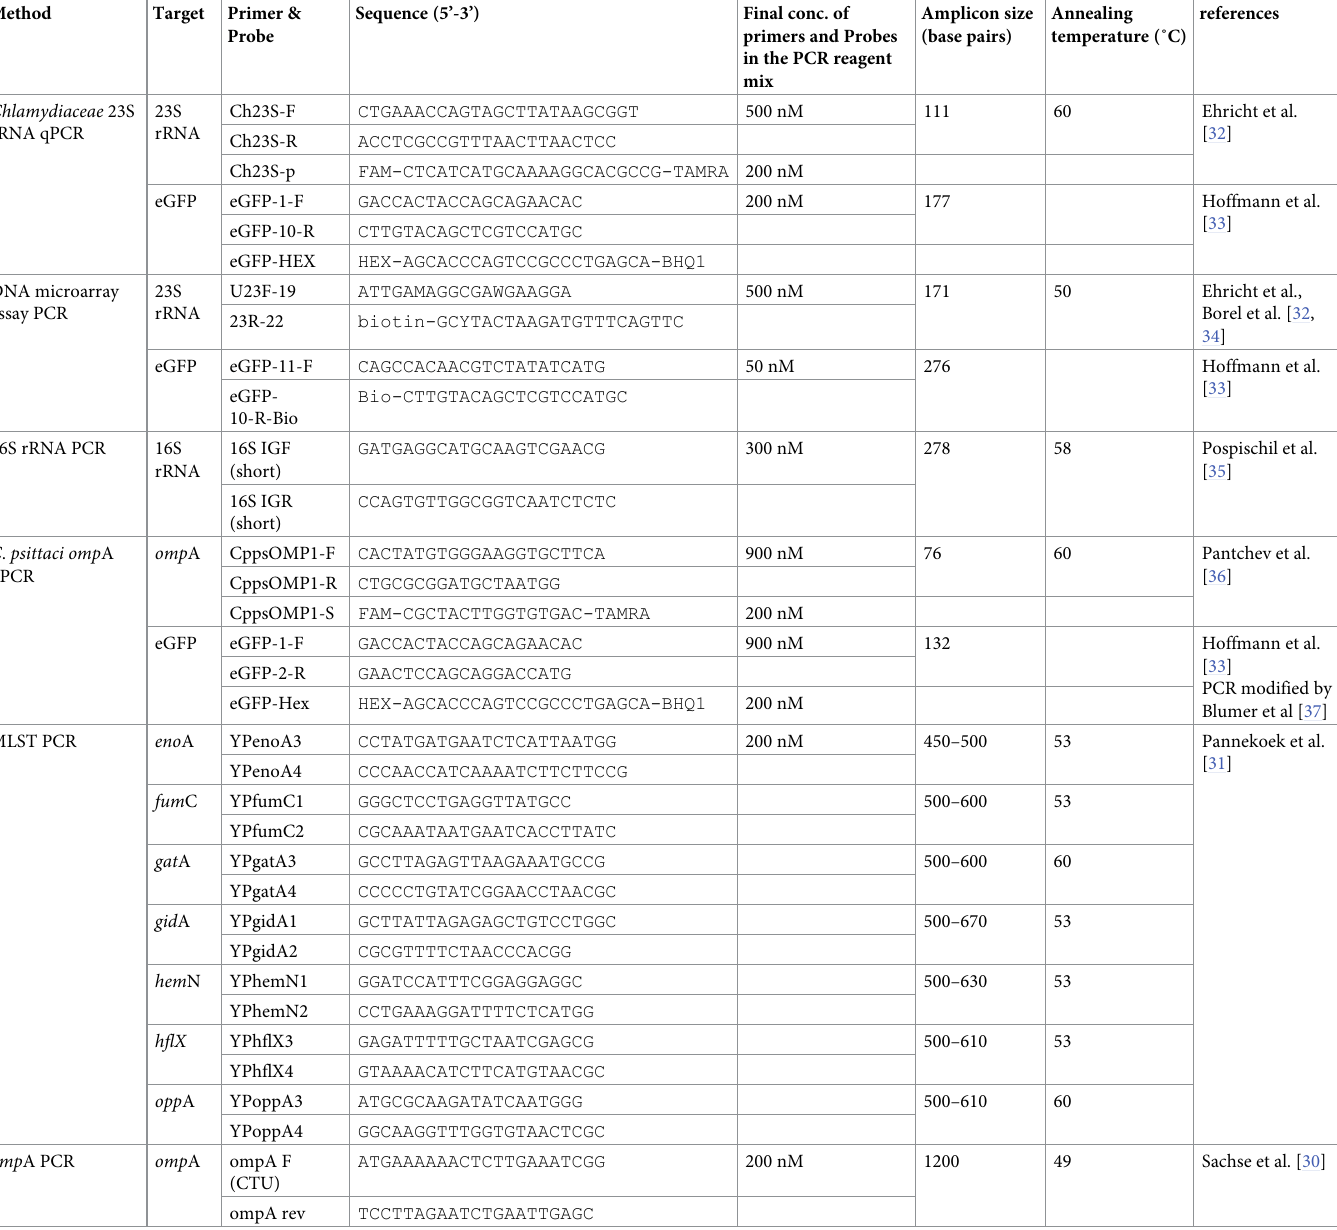
Table 2. Primers and probes and their final concentration (nM) in the PCR reagent mix for different quantitative PCR (qPCR) and conventional PCR (PCR) tests used in this study.